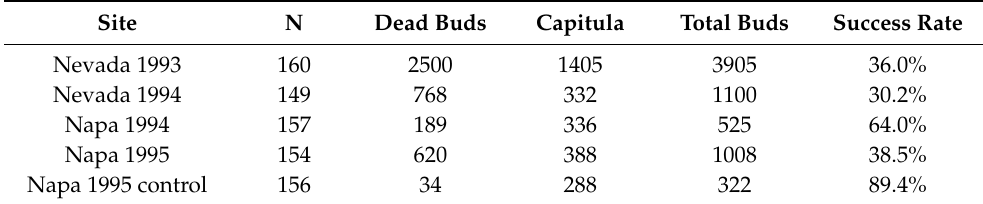
Napa 1995 control 156 34 288 322 89.4%